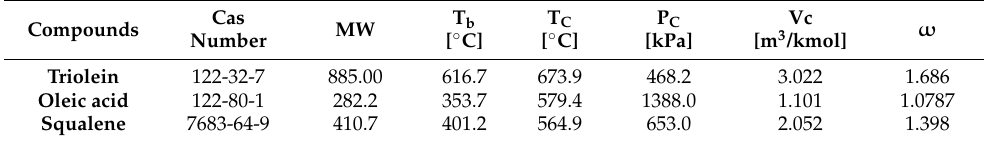
Table 10. Estimated/Predicted values of thermo-physical (T b ), critical properties (T c , P c , V c ), and acentric factor ( ω ) of olive oil key (oleic acid, squalene, triolein) compounds [81–85].